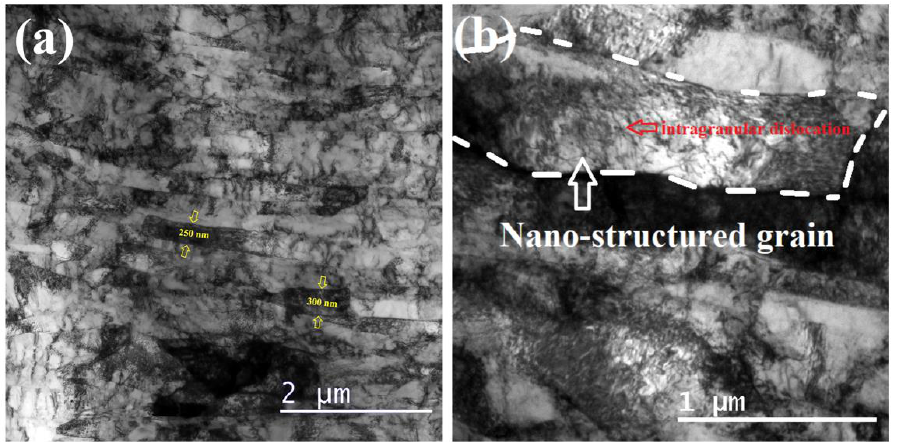
Figure 12. TEM microstructure characteristics of the SNC rebar: ( a ) grain morphology; ( b ) intragran- ular microstructure characteristics. ular microstructure